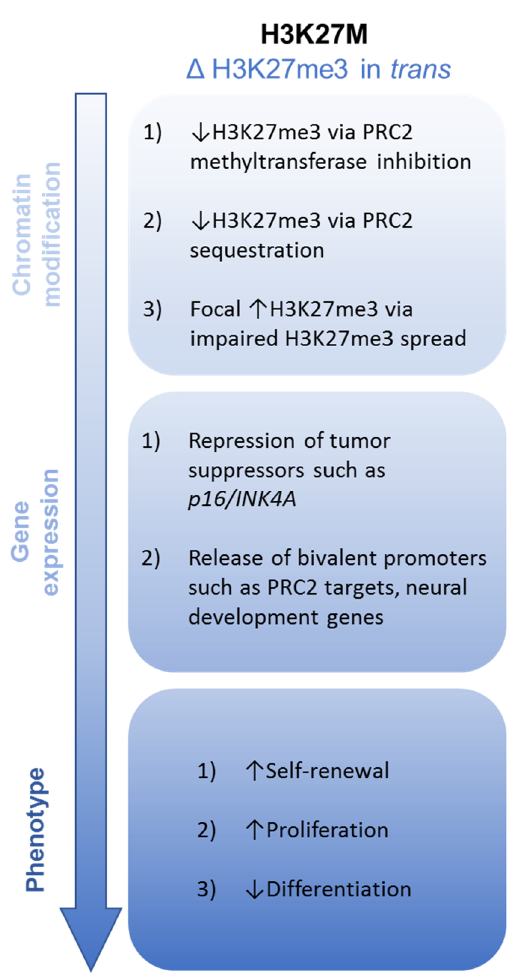
Figure 2. Putative oncogenic mechanisms of H3K27M in pHGG.